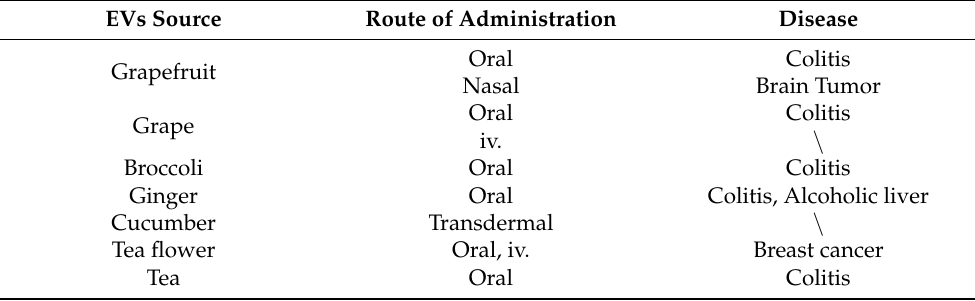
Table 4. Administration and Inhibitive Diseases of Different Plant derived